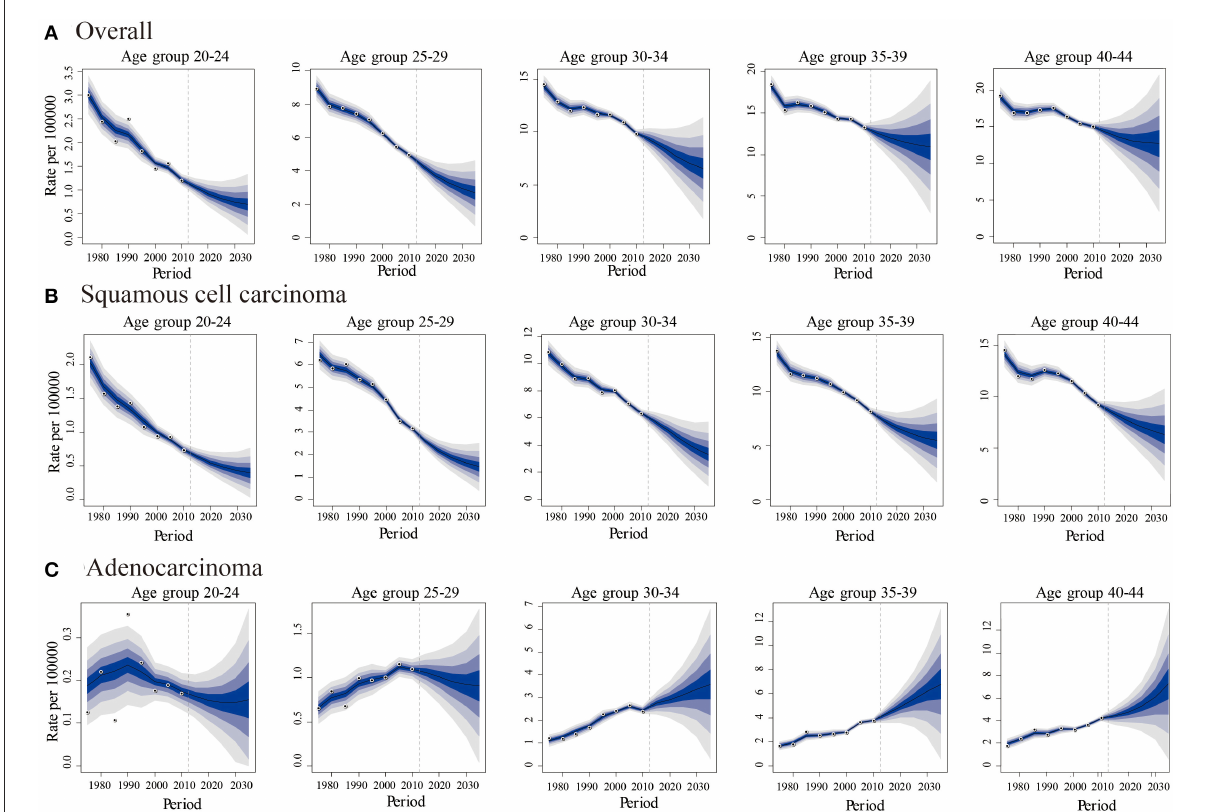
FIGURE8 Predicted trends in cervical cancer incidence rates (2015-2039) among females aged 20 to 44 years by age and histology, United States. (A) Predicted trends of all histopathologic subtypes combined. (B) Predicted trends of squamous cell carcinoma (SCC) (C) Predicted trends of adenocarcinoma (AC). All data are expressed as the rate per 100,000. The fan represents the predictive distribution between the 5% and 95% quantiles. Each shaded band represents an additional 10% quantile. The solid line shows the predictive mean, and the white dot represents the observed incidence. The vertical dashed line indicates 2014, when prediction